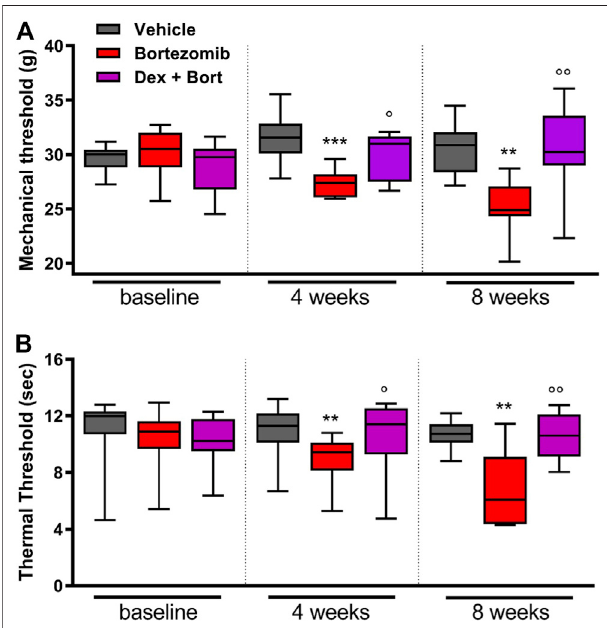
FIGURE 5 | Ef fi cacy of dexanabinol for preventing bortezomib-induced mechanical allodynia and thermal hyperalgesia in rats. Mechanical threshold (grams)wasdeterminedusingdynamictestatbaseline,4 weeksoftreatment, and 8 weeks of treatment (A) . The withdrawal latency to an infrared heat stimulus(seconds)wasdeterminedusingadynamicplantaranalgesiometerat baseline, 4 weeks of treatment, and 8 weeks of treatment (B) . Bortezomib (Bort) was administered IV (0.2 mg/kg) three times a week, and dexanabinol (Dex) was administered IP (10 mg/kg) three times a week approximately 30 min prior to bortezomib. GraphPad prism v7.04 was used to perform a Kruskal-Wallis test with Dunn ’ s correction for multiple comparisons across all groups. p values are reported as: Bort vs vehicle (Vehicle), ** ( < 0.01), *** ( < 0.001) and Bort vs Dex + Bort, ○ ( < 0.05), ○○ ( < 0.01).